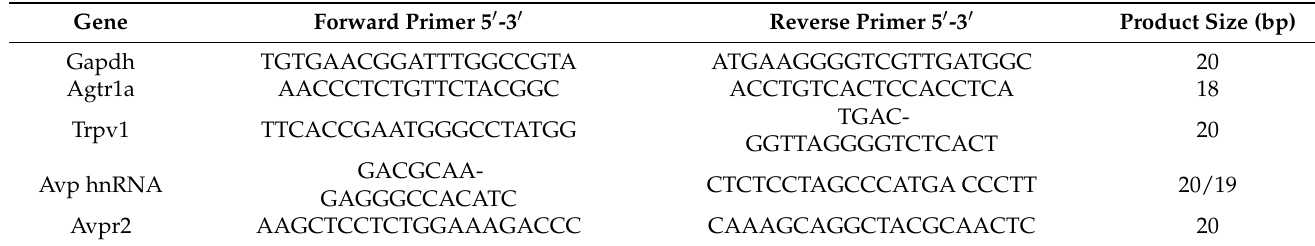
Table 1. Primer pairs for Agtr1a, Avpr2, Trpv1, Avp hnRNA, and Gapdh